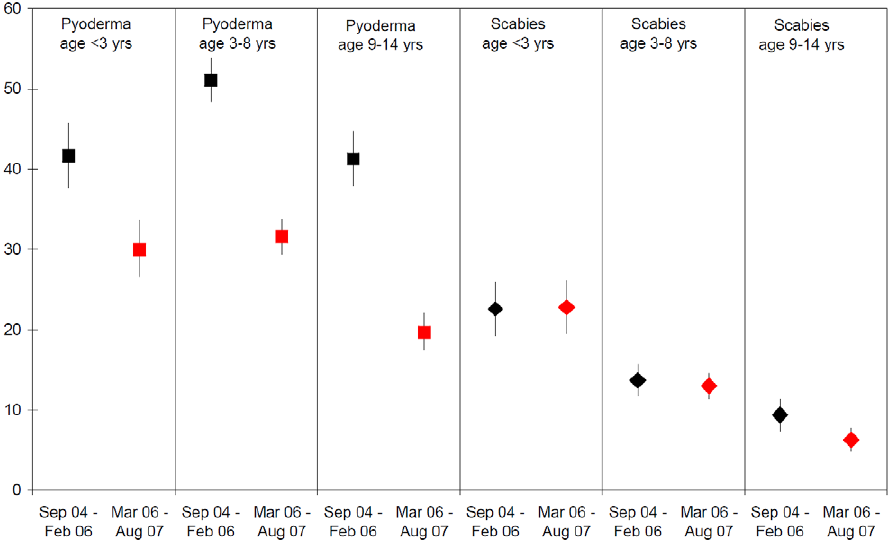
Figure 4. Average monthly prevalence of pyoderma and scabies by age group and month of screening. n=6038 assessments conducted through community based surveillance for the East Arnhem Healthy Skin Project from September 2004–August 2007. doi:10.1371/journal.pntd.0000554.g004 (Table 2). For those with five or more sores, this was an absolute overall reduction in crusted or purulent pyoderma (10%) there was increase in treatment uptake equivalent to 13 children per 100 not a demonstrable increase in treatment uptake for these children seen (95%CI 3.3,23.6). By comparison, although there was an (3.5%, 95%CI 2 0.7,7.6).